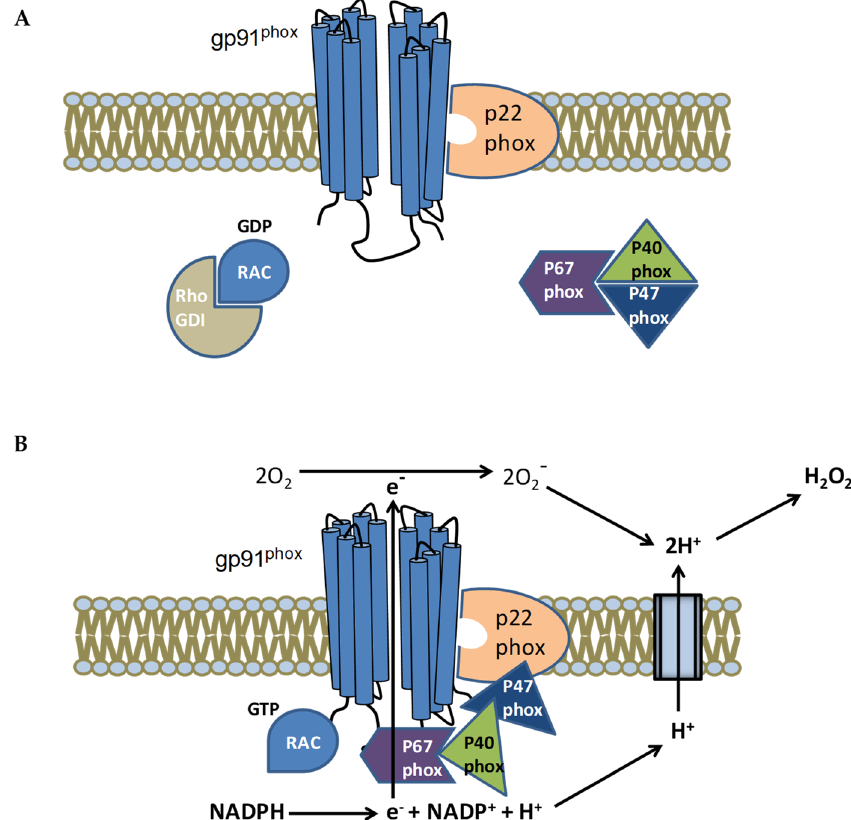
Figure 1. The NADPH oxidase (NOX) activation complex in the cytoplasmic membrane of a phagocyte is depicted in a schematic form. ( A ) The oxidase complex is inactive in the absence of stimuli, with gp91phox and p22phox attached to cell membranes and p67phox, p47phox, and p40phox in the cytosol. ( B ) The cytosolic p47phox subunit is phosphorylated in response to inflammatory stimuli, which activates NADPH oxidase and causes the assembly of all cytosolic components (p67phox, p40phox) to p22phox/gp91phox. Rac is also bound in conjunction with this. The active enzymatic complex moves electrons from the cytosol to phagosome lumen, where oxygen (O 2 ) is changed into superoxide anion and then hydrogen peroxide (H 2 O 2 ).